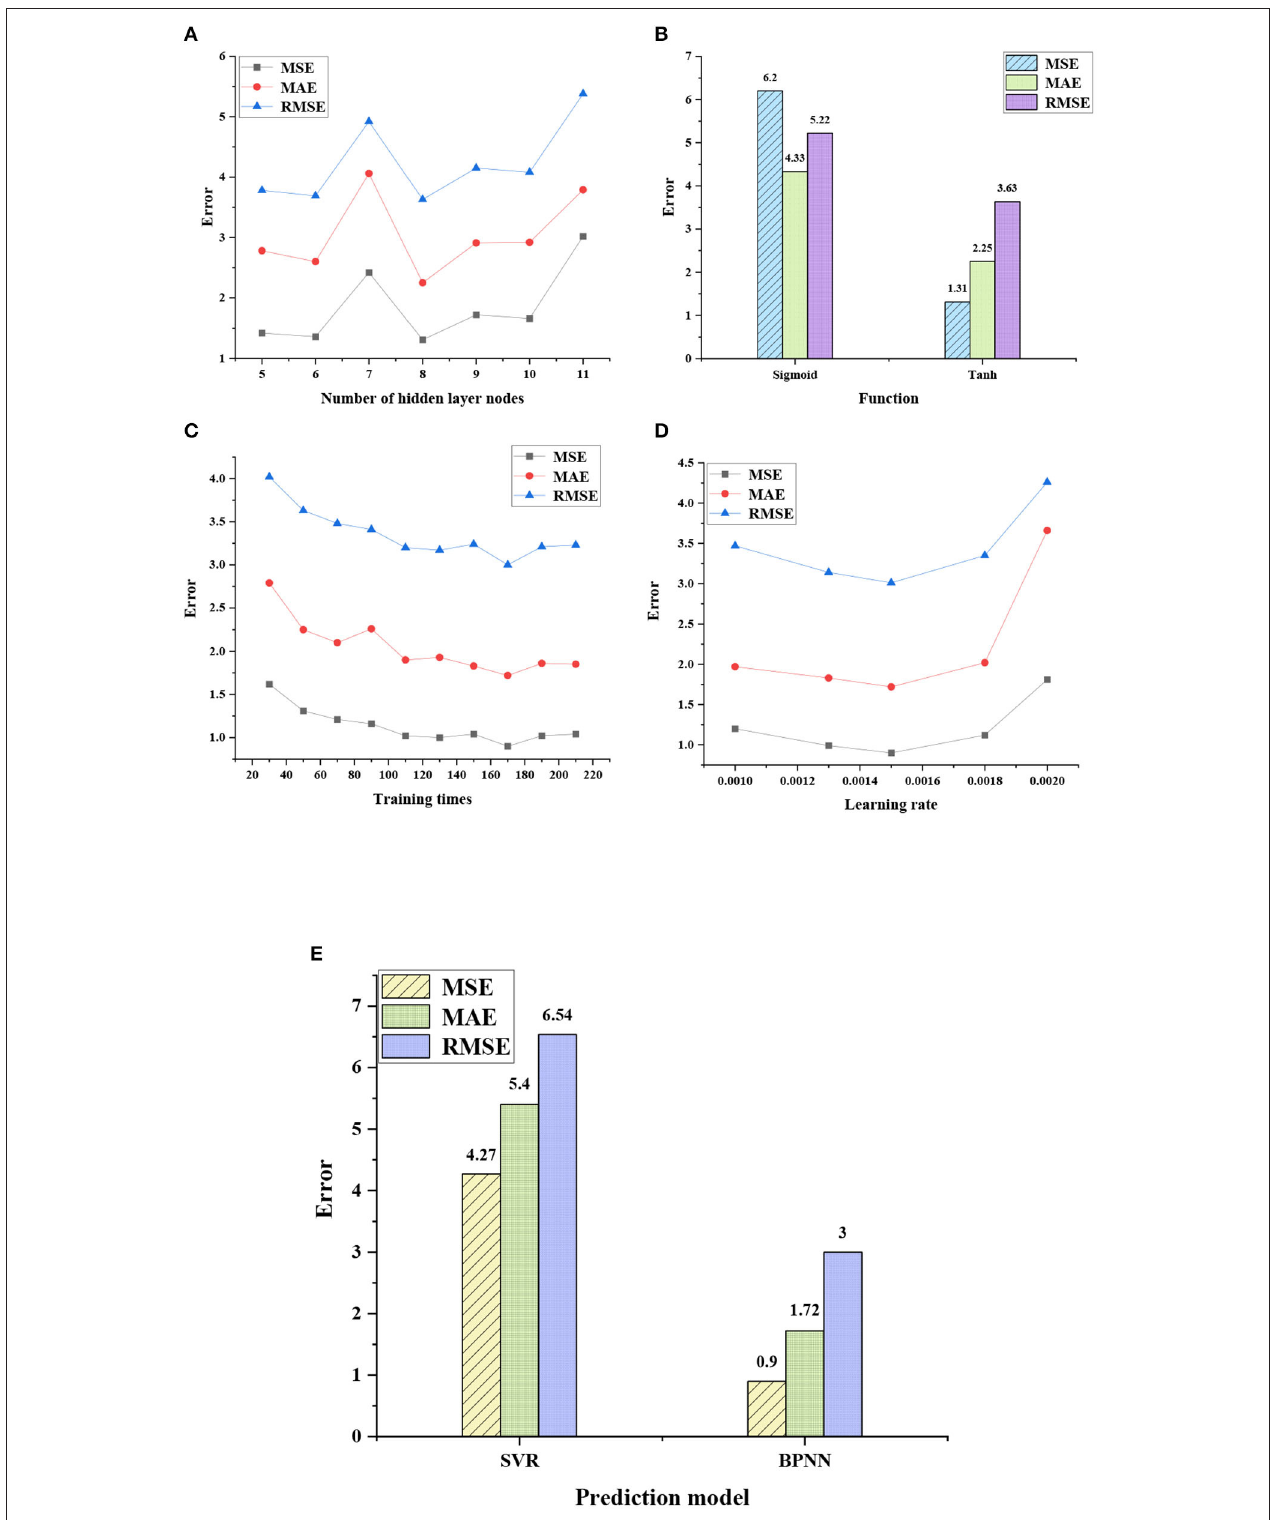
FIGURE 4 | Performance test results of the model under different parameters. (A) Optimization result of nodes in the hidden layer; (B) Optimization result of activation function; (C) Optimization result of training times; (D) Optimization result of learning rate; and (E) Comparison of prediction performance of the two models.